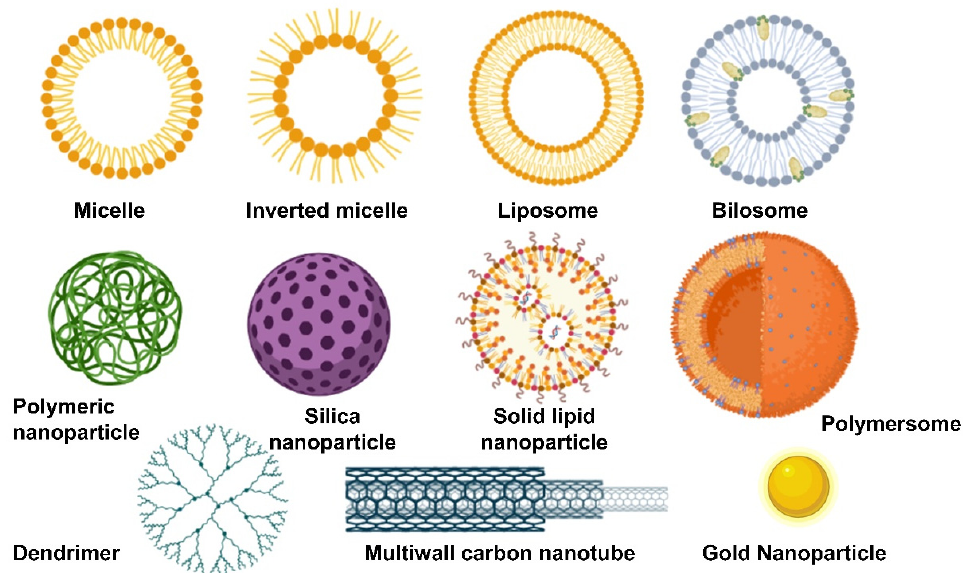
Figure 7. Types of organic and inorganic nanomedicines.